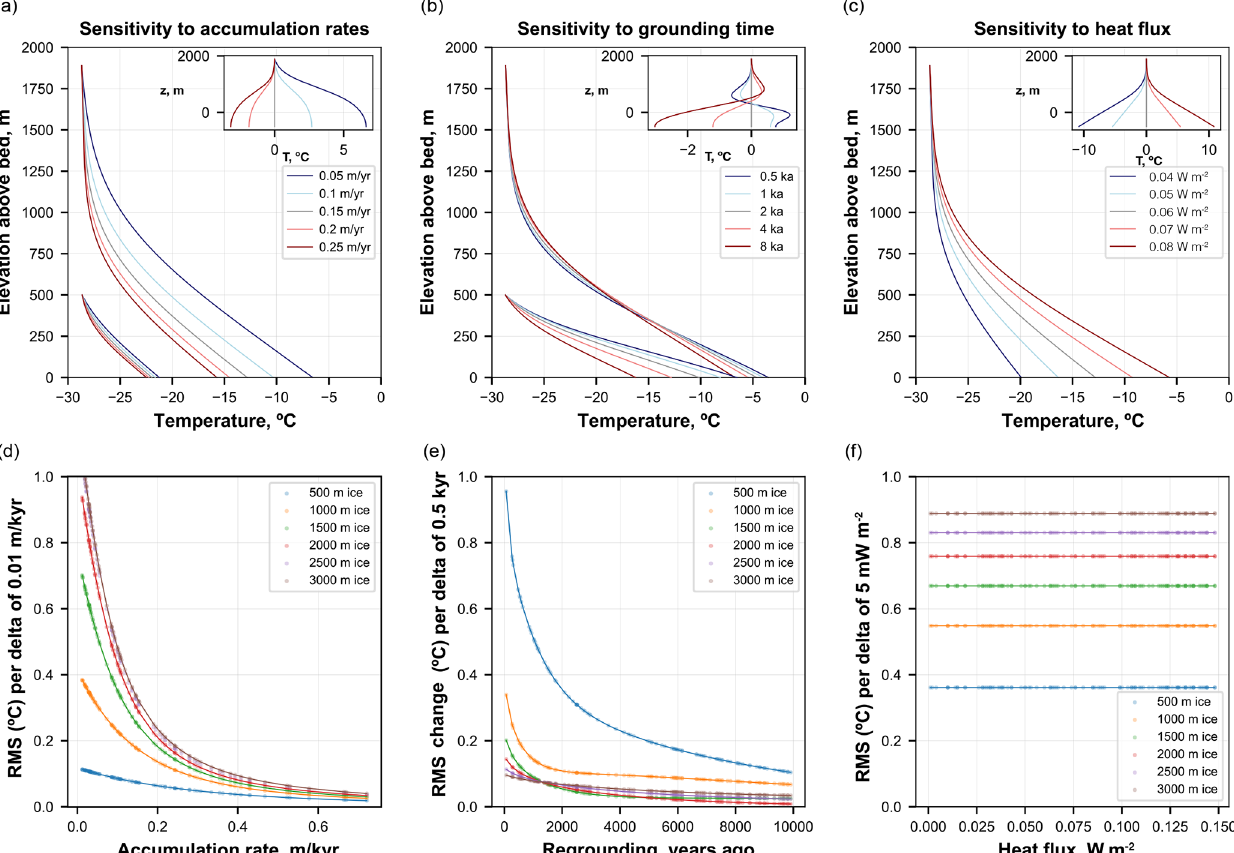
Figure 5. Englacial vertical temperature profile sensitivity to model parameters. (a, b, c) Example of five temperature profiles (with differ- ences in the inset) obtained using a forward model for grounded ice with only the following parameter varied, while other variables remain constant at their mean value: (a) accumulation rate, (b) timing of grounding and (c) heat flux. (d, e, f) Results of forward simulations show- ing how a change (termed “delta” on the vertical axis label) in (d) accumulation rate of 0.01mkyr − 1 , (e) timing of grounding of 500 years and (f) geothermal heat flux of 1mWm − 2 affects temperature profiles within grounded ice (expressed as root-mean-squared (rms) change between two